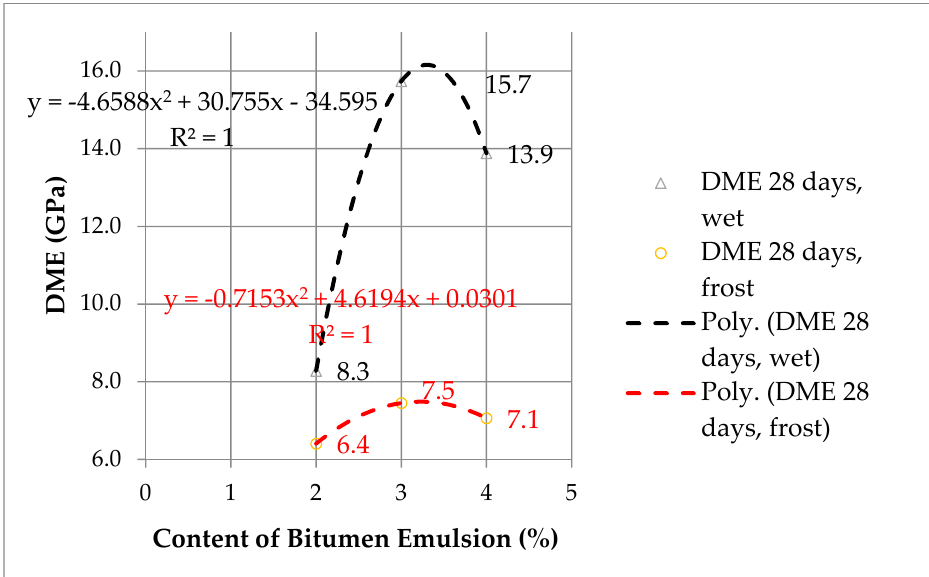
Figure 6. Dependence of dynamic modulus of elasticity (DME) on emulsion content, wet specimens, and specimens exposed to frost.